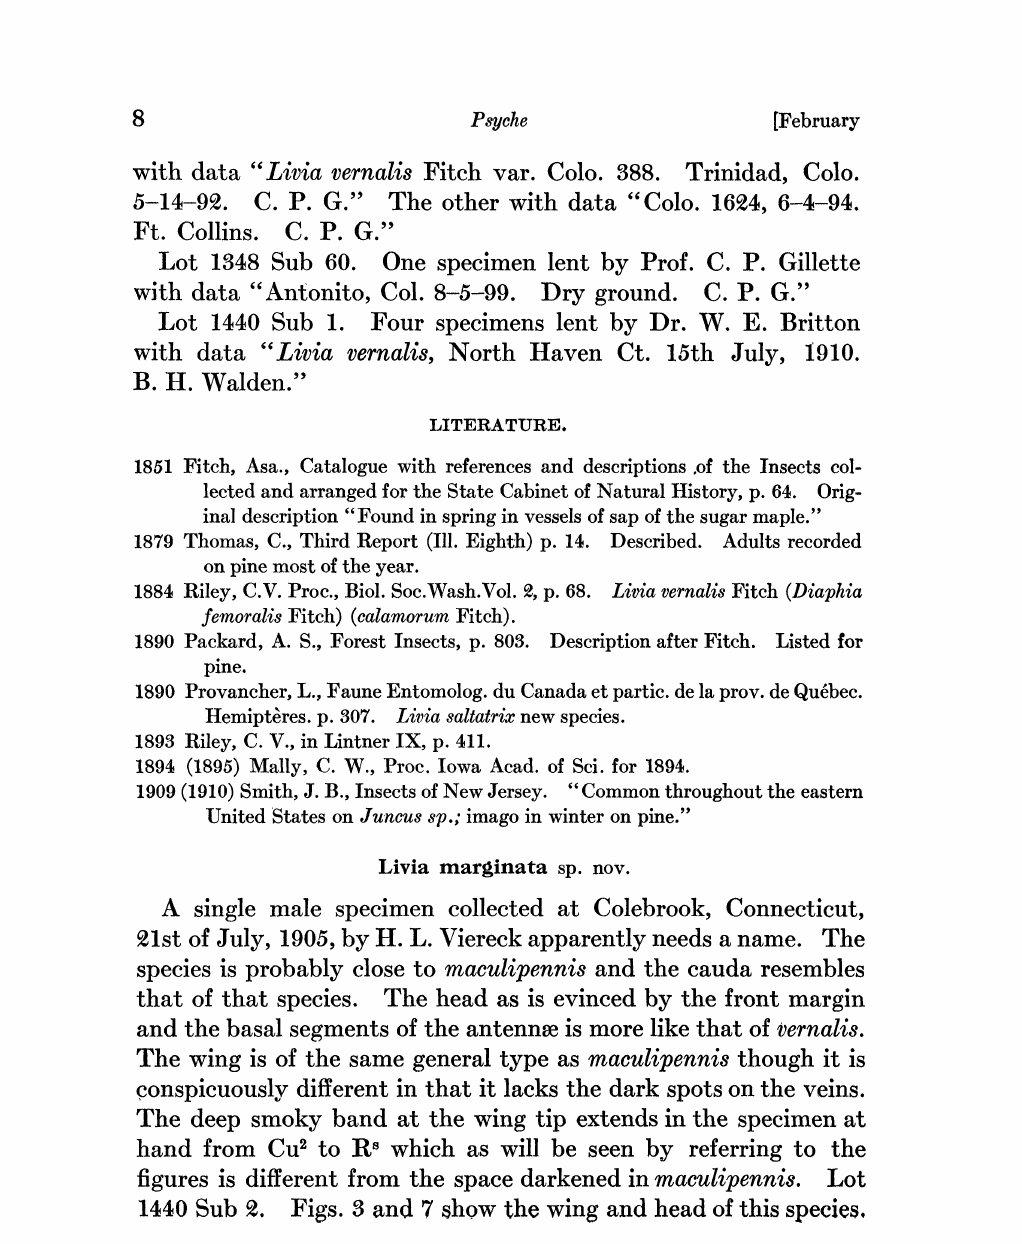
Figs. 3 and 7 how the wing and head of this